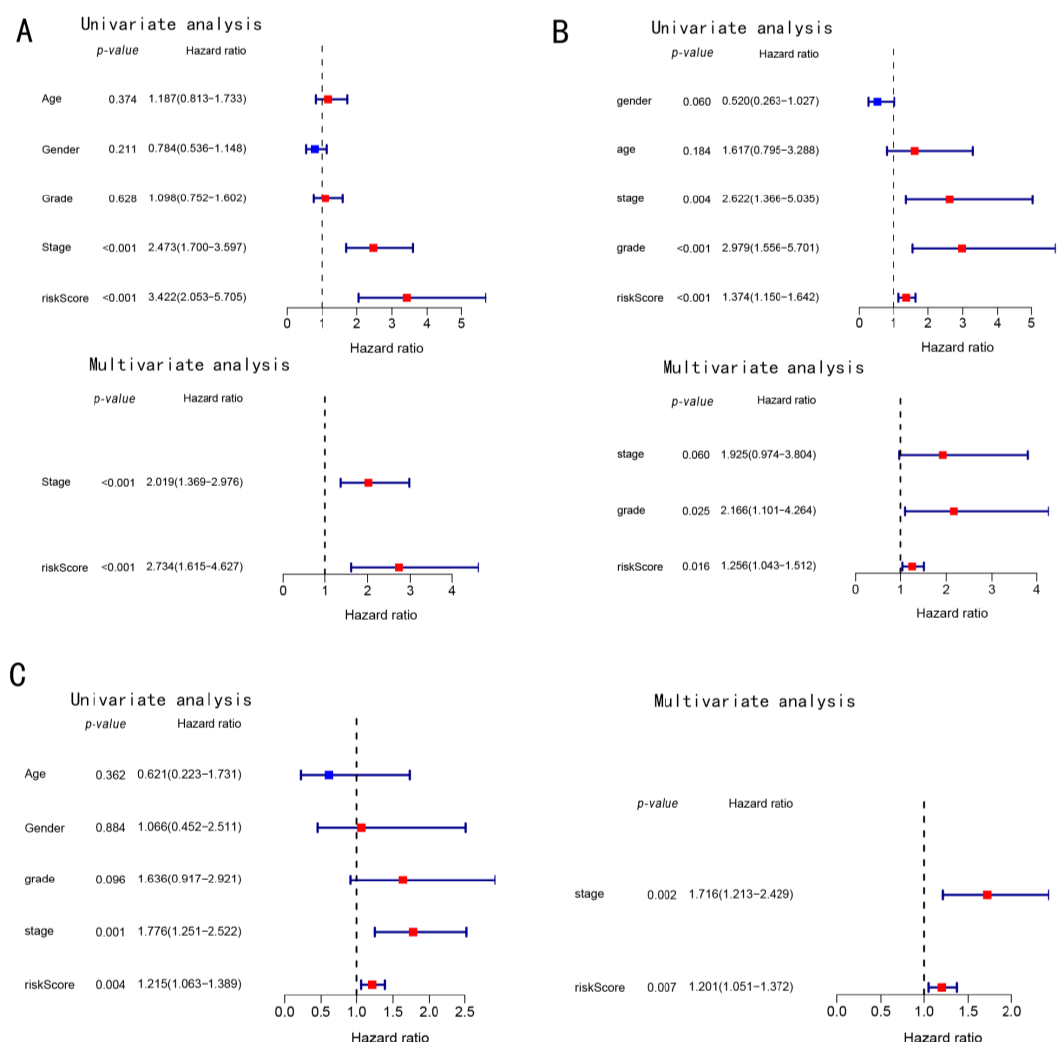
Figure 5. Univariate and multivariate Cox regression analysis of the ( A ) TCGA cohort data, ( B ) ICGC cohort, and ( C ) in-house cohort data.